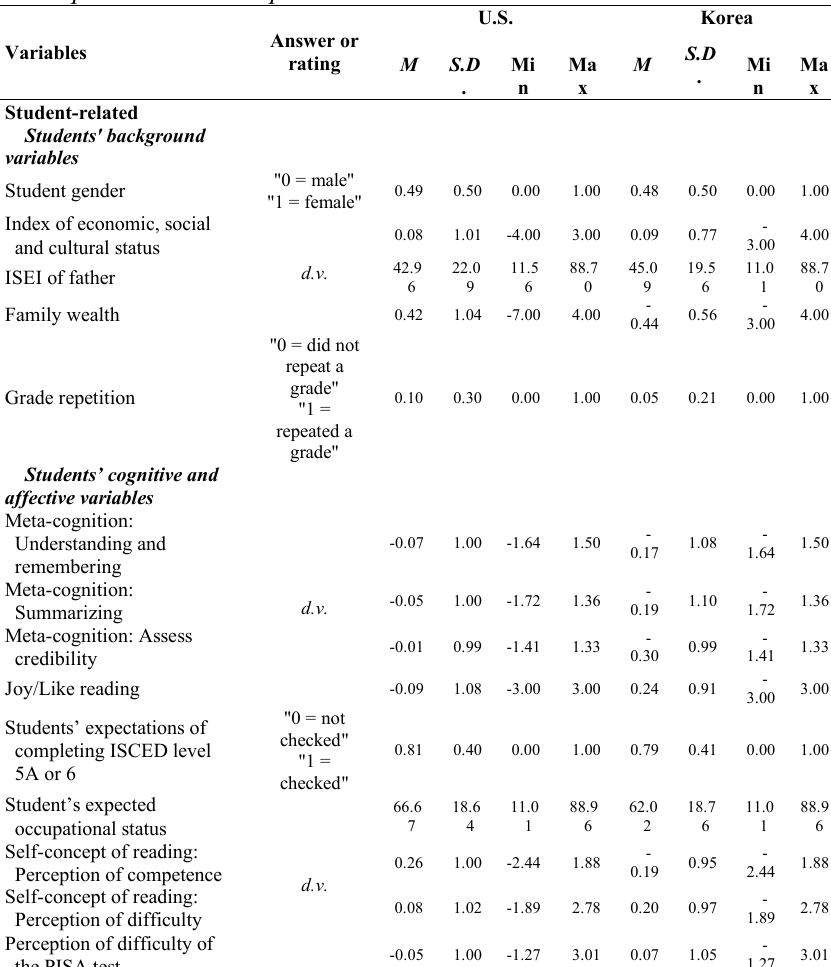
Descriptive statistics on